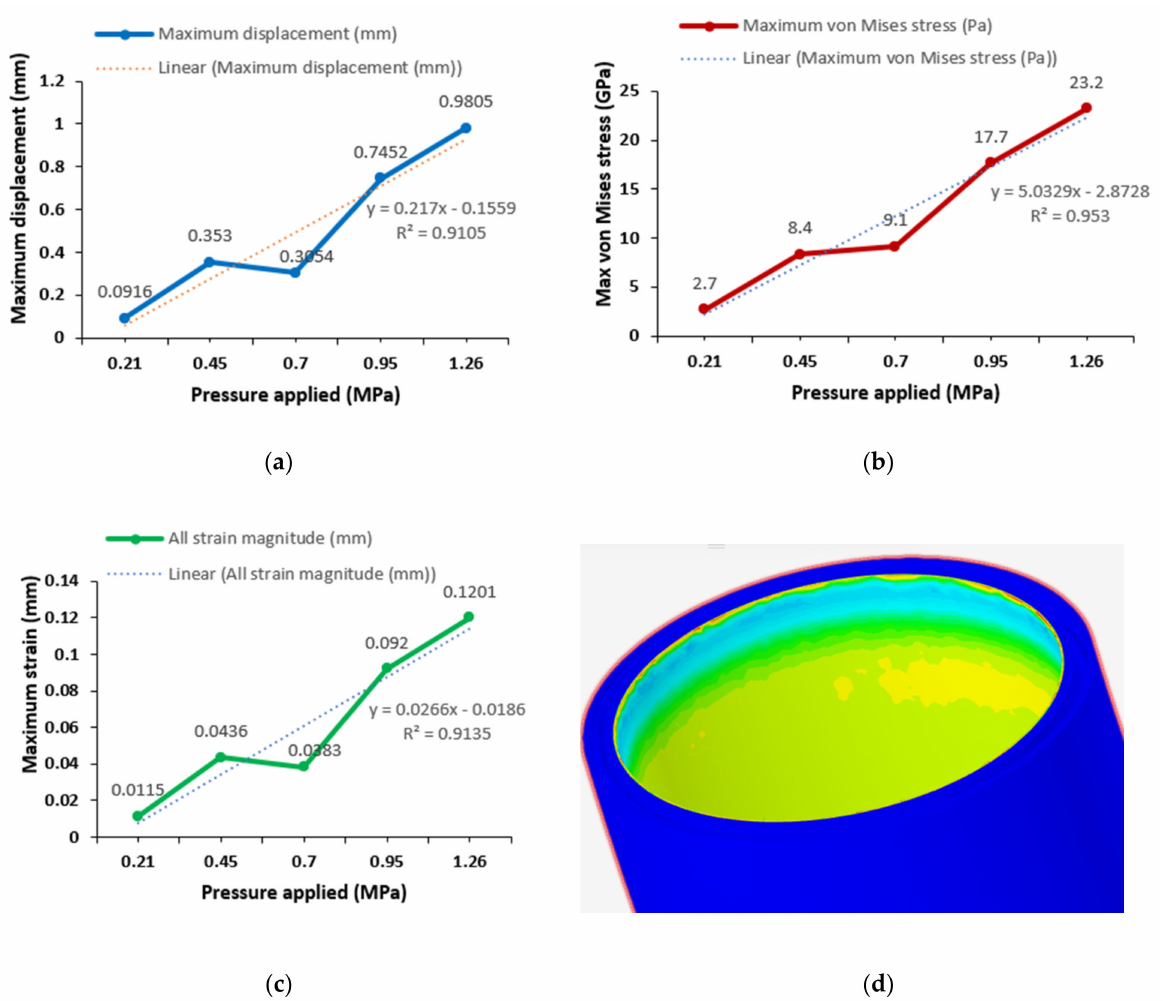
Figure 19. Profile distribution of Bonded flexible hose under external pressure showing ( a ) Deforma- tion ( b ) Max von Mises stress, ( c ) Max strain magnitude, ( d ) Section of Von Mises Stress (VMS)